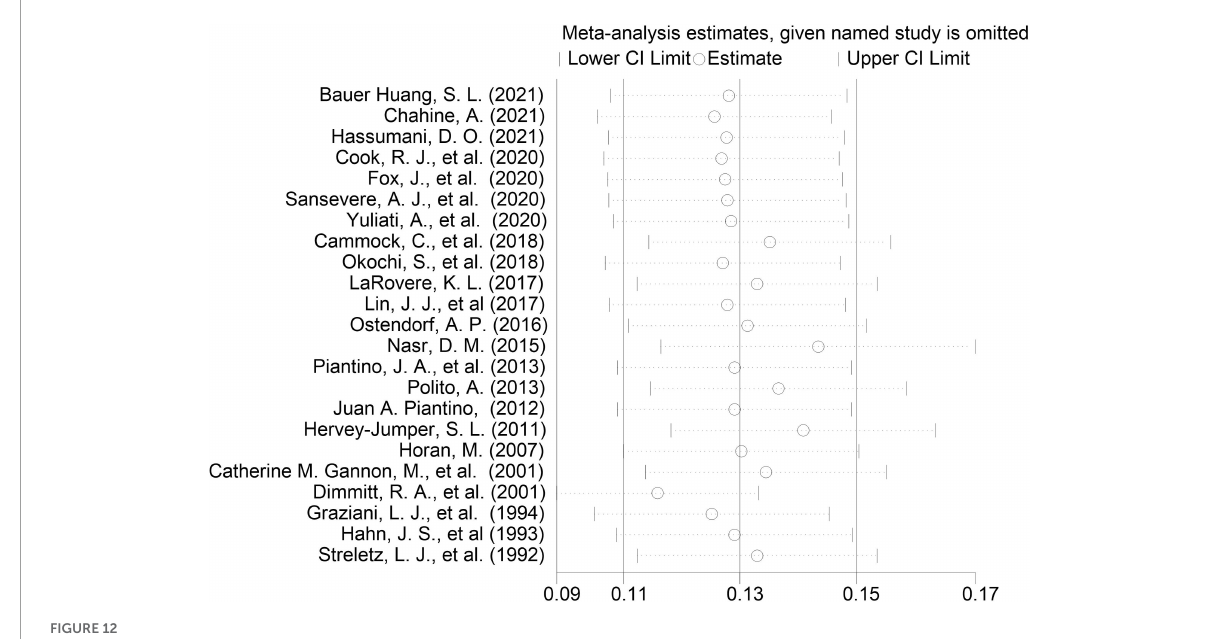
FIGURE12 Influence analysis of extracorporeal membrane oxygenation (ECMO) in pediatrics.